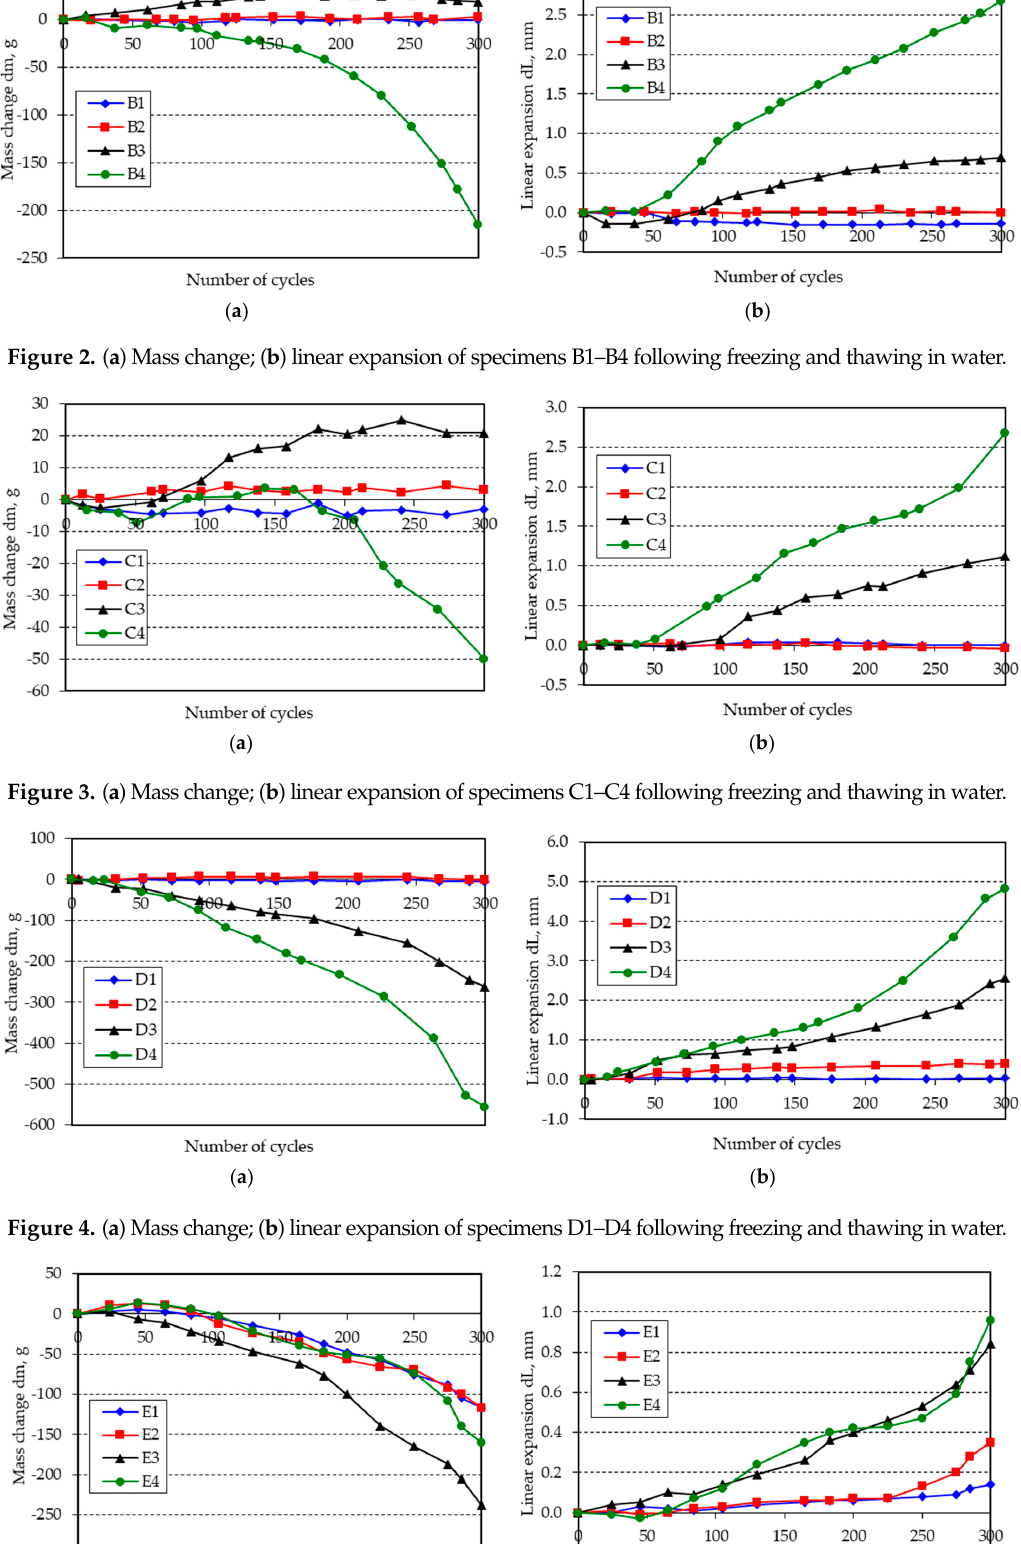
( b ) Figure 6. ( a ) Mass change; ( b ) linear expansion of specimens F1–F4 following freezing and thawing in water. 4. Discussion The freeze-thaw resistance assessment was carried out for non-air-entrained concretes made with cements of different GGBS content (A, B, C, D series) and for concretes made with CEM I cement and GGBS addition (E and F series). Figure 7 shows the results of the freeze-thaw resistance tests: mass changes dm and linear expansion dL for individual series of concrete specimens. Assuming the limiting values are dm =